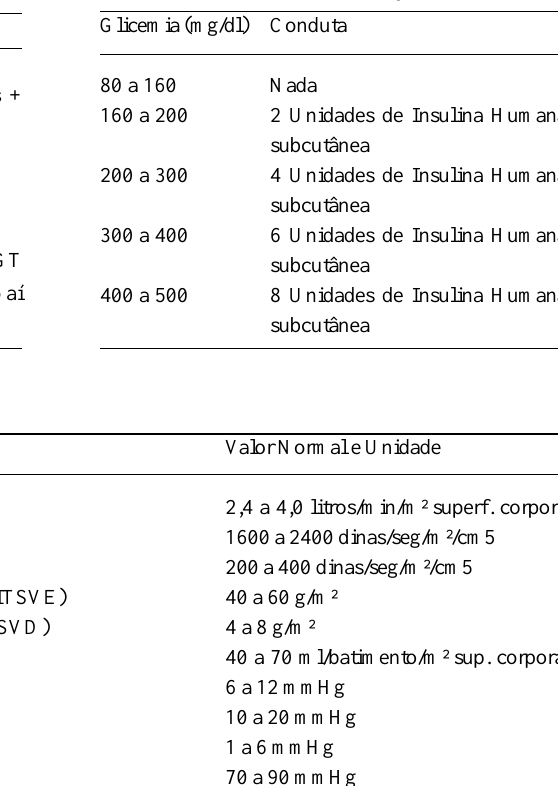
Tabela 2. Escala para administração da insulina SC (controle)